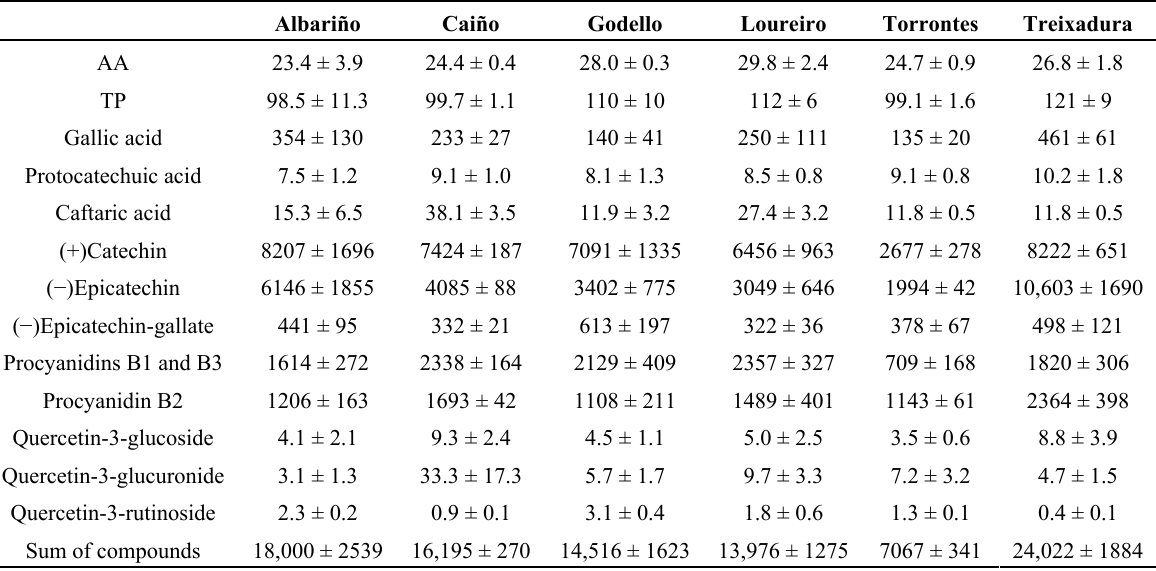
Table 2. Antioxidant activity and polyphenolic composition of Galician varietal white grape seed samples (mean ± standard deviation, n =